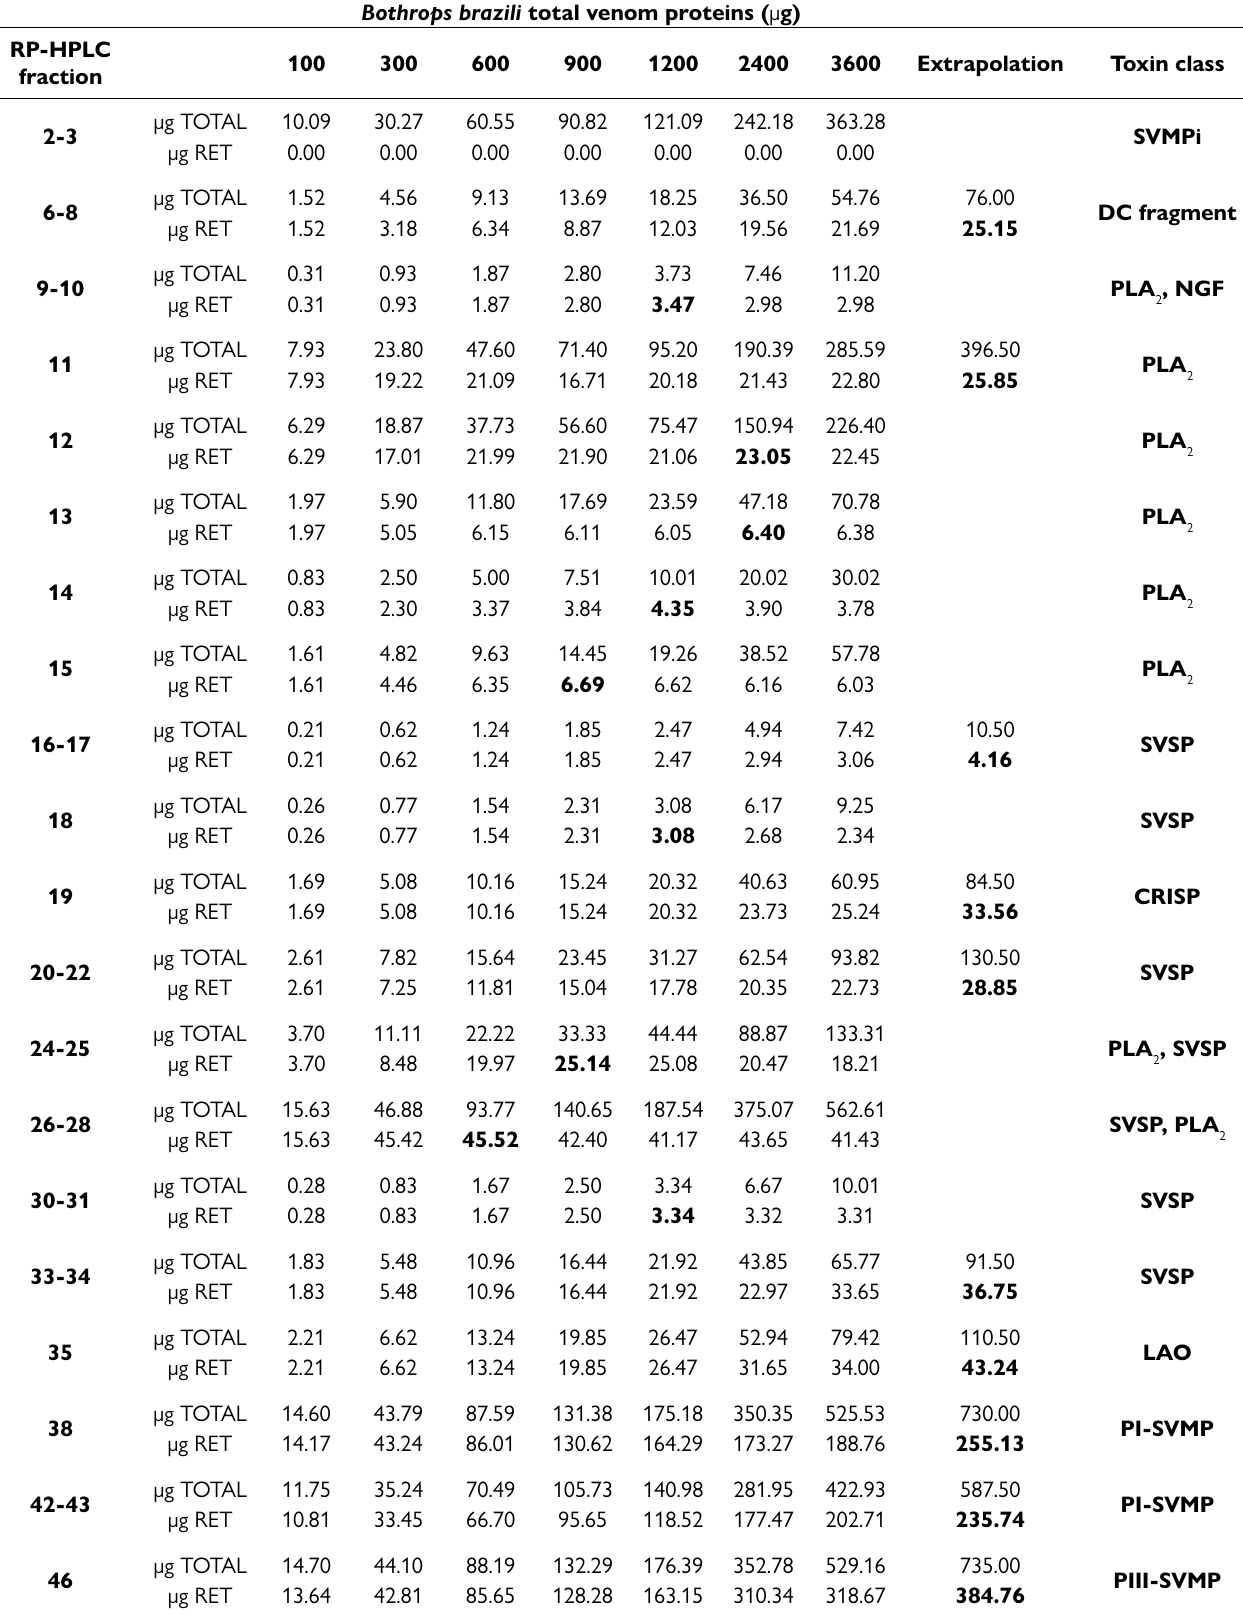
Table 1. Concentration-dependent immunoretained (RET) Bothrops brazili (Bbr) venom proteins by SAB antivenom affinity column. Maximal binding for each RP-HPLC fraction is highlighted in bold face Bothrops brazili total venom proteins ( μ g)